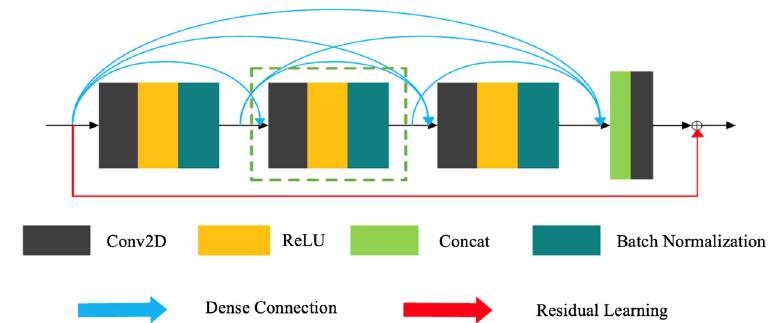
Figure 4. Structure of a residual dense block.